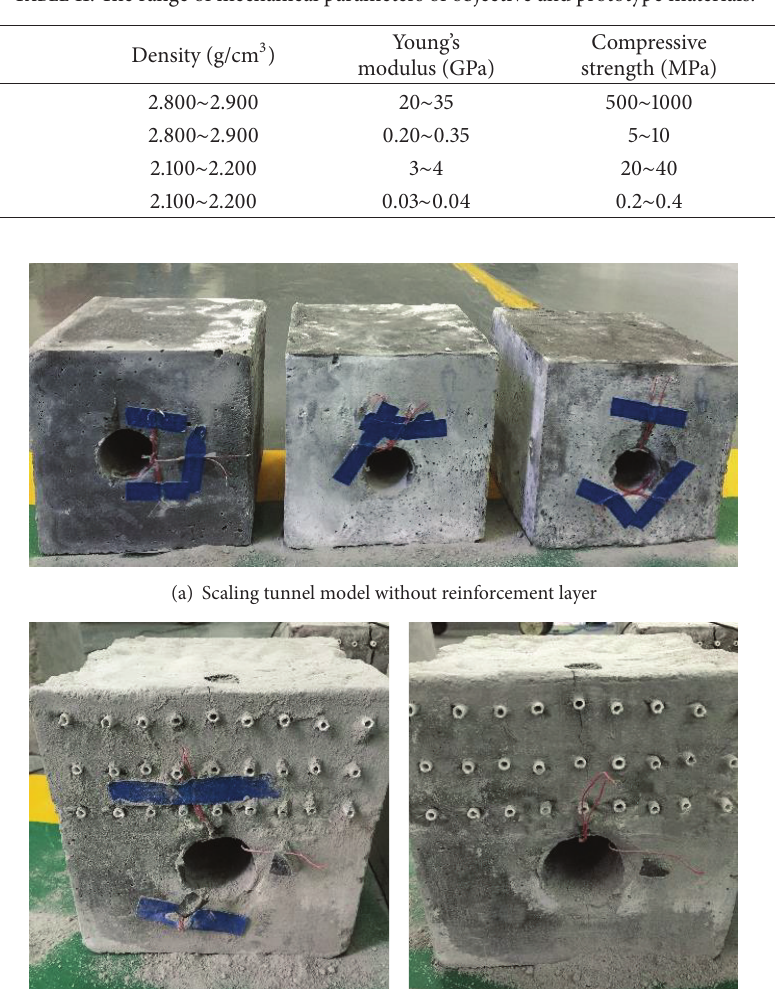
Table 11: The range of mechanical parameters of objective and prototype materials.